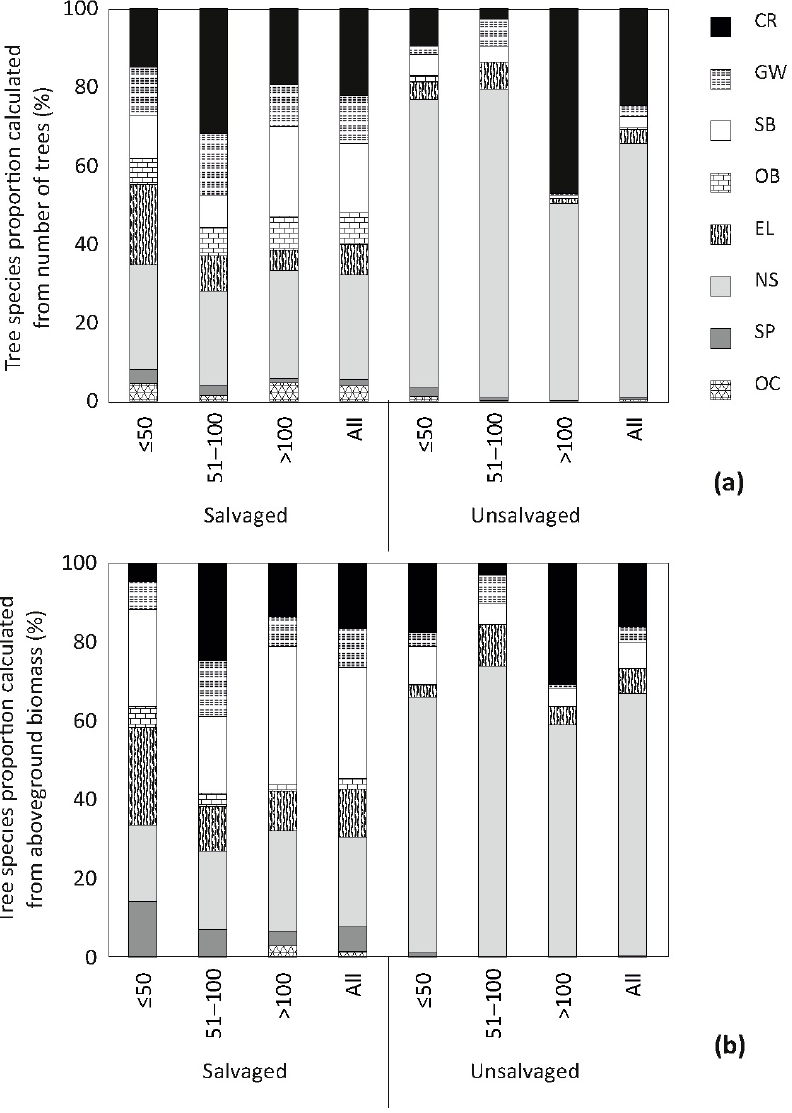
Figure 4. Mean tree species composition at salvaged and unsalvaged plots quantified from number of trees ( a ) and aboveground biomass ( b ) in three classes of tree densities (less than 50 individuals pre are, 51 to 100 individuals per are, more than 100 individuals per are, the High Tatra Mts. in 2019). See Table 2 for explanation of tree species abbreviations. When considering tree species composition for all salvaged and unsalvaged MPs, clear differences between two types of MP were found. Contribution of spruce at unsal- vaged MP was more than twofold of its share at salvaged MP (Figure 4a,b). Rowan had a very similar contribution at both types of MP (25% or 16% and 22% or 17% at salvaged and unsalvaged MPs calculated from the number of trees or biomass, respectively). All